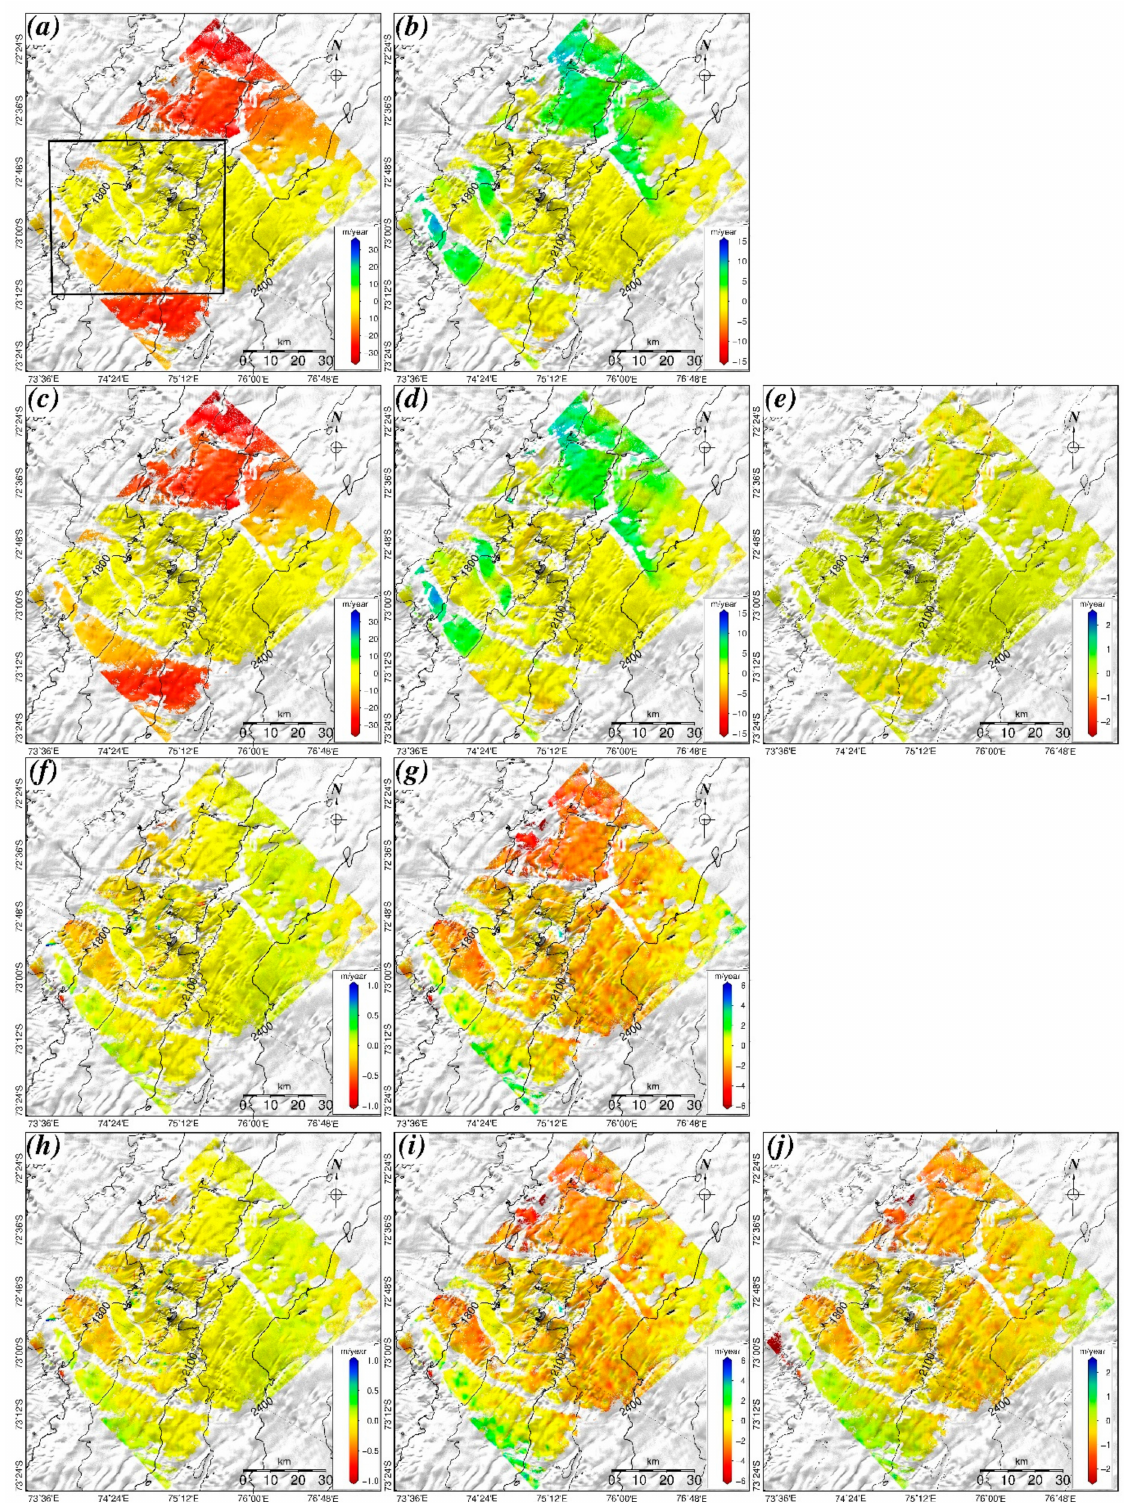
Figure 7. 2D ice velocities derived by ignoring vertical deformation in the eastern ( a ) and northern ( b ) directions, and quasi-3D ice velocities derived on the basis of the SPF assumption along the eastern ( c ), northern ( d ), and vertical ( e ) directions. ( f , g ) show the differences between the complete 3D and 2D results in the eastern and northern directions, respectively. ( h – j ) show the differences between the complete 3D and quasi-3D results in the eastern, northern, and vertical directions,